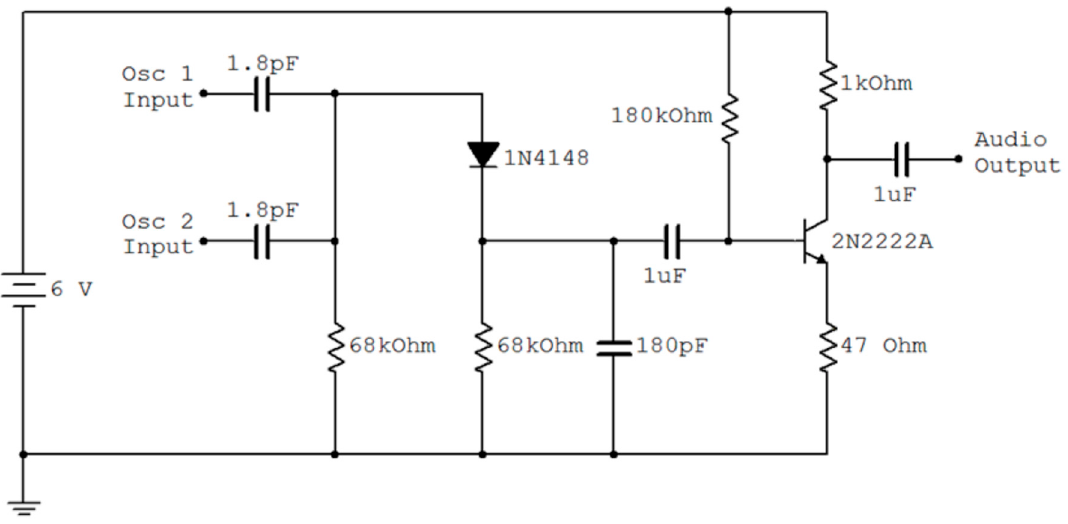
Figure 8. Mixer, filter and buffer circuit diagram